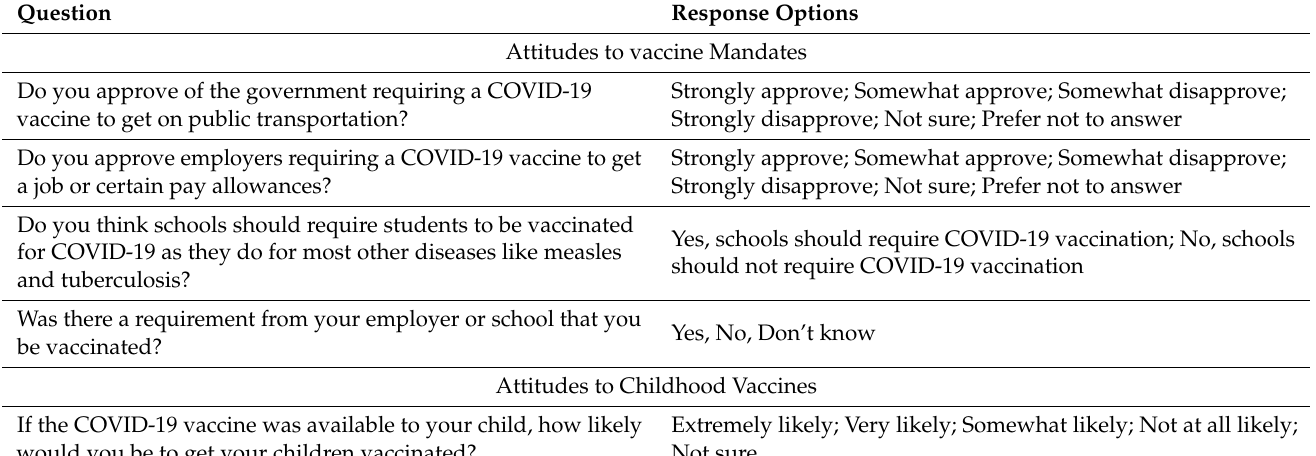
Table 1. Survey questions addressing vaccine